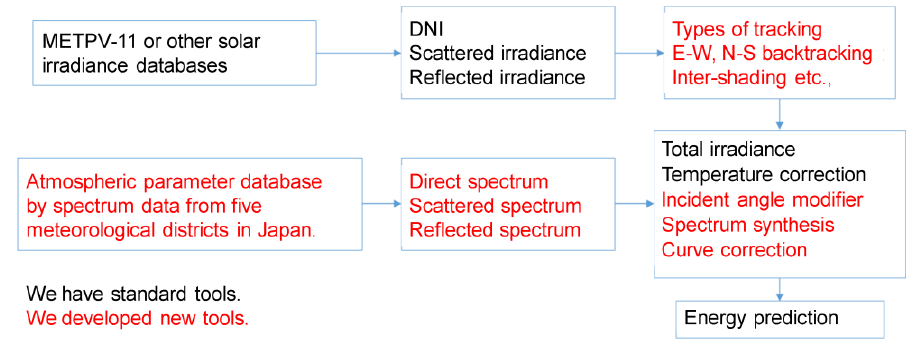
Figure 5. The performance model of the tandem solar cells, considering the spectrum and angle interaction [1].